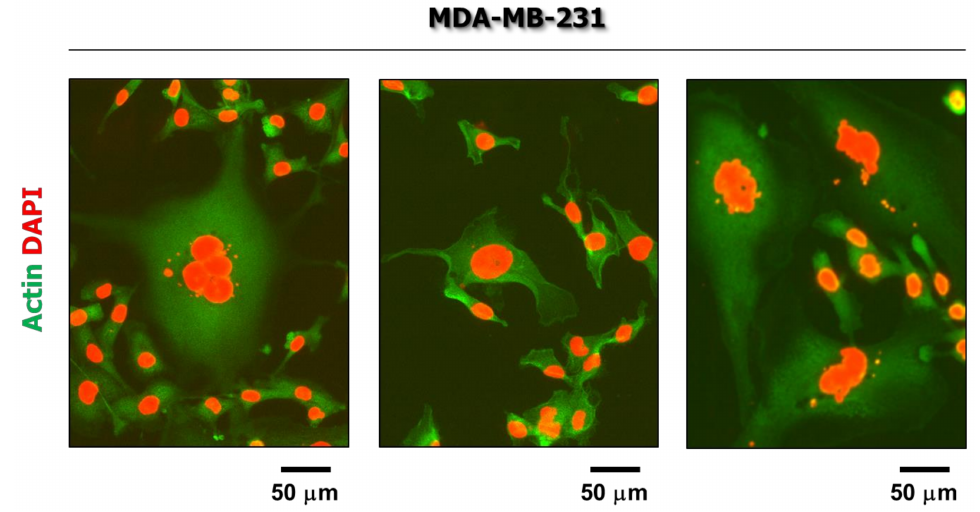
Figure 3. Fluorescence images showing the presence of giant cells in non-stressed cultures of the MDA-MB-231 breast carcinoma cell